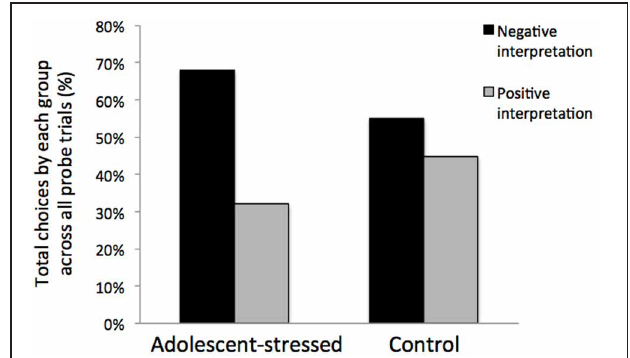
FIGURE 6 | Interpretation of an ambiguous stimulus during all cognitive bias testing days. Rats that experienced stress during adolescence trended toward a negative cognitive bias across the 5 day testing period.